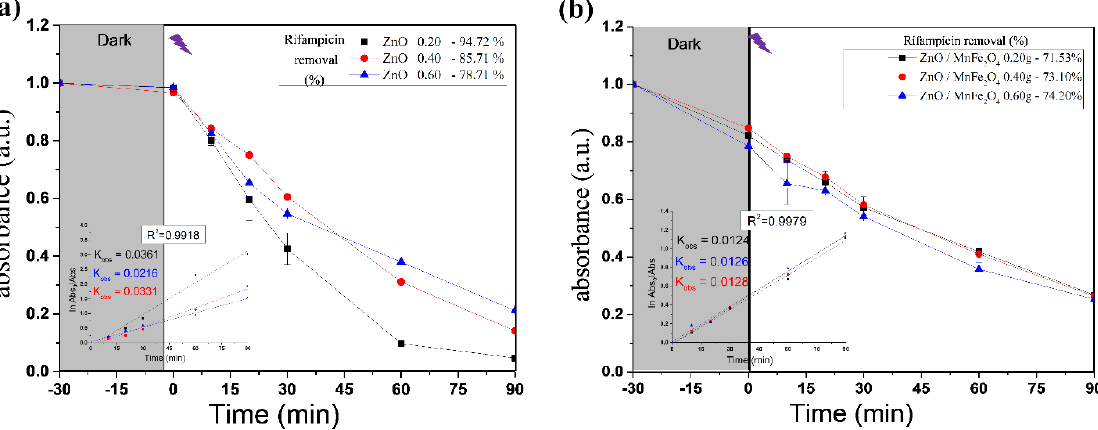
Figure 6. Rifampicin removal curves of photocatalytic tests by ( a ) ZnO; ( b ) ZnO/MnFe 2 O 4 . Inset — Pseudo-first order rate at time <90 min. and k obs (min − 1 ) as function of catalyst dosage.